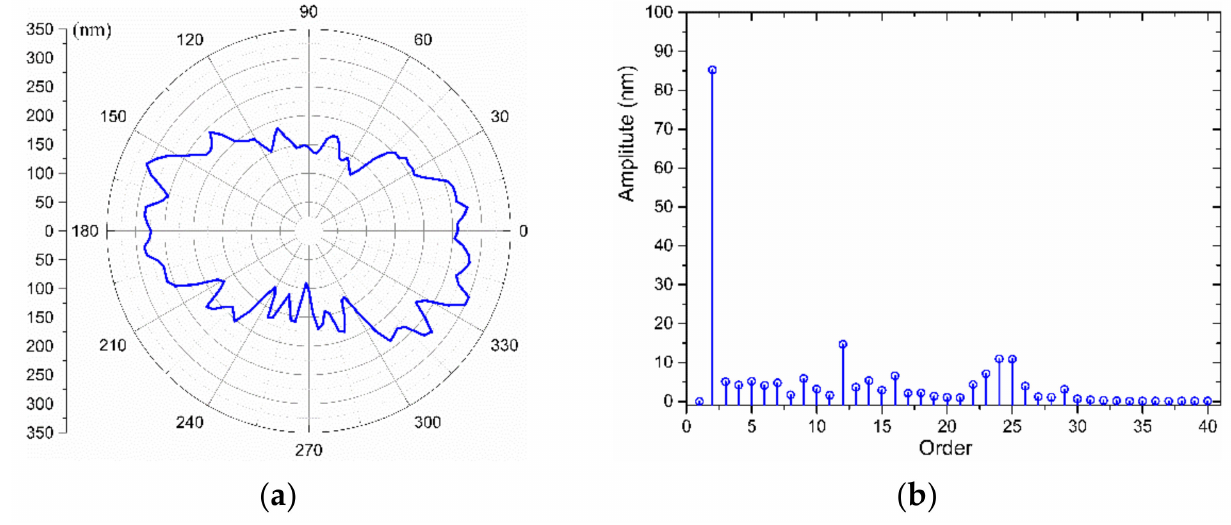
Figure 15. The WRE of the mandrel and its spectrum: ( a ) WRE graph in a polar coordinate system, ( b ) Error spectrum.